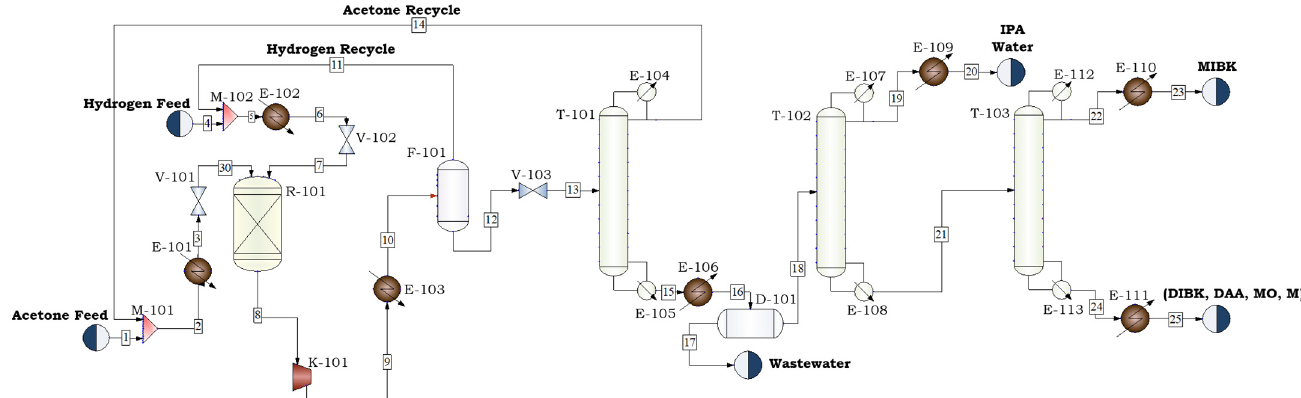
Figure 1. Developed process flow diagram (PFD) of the MIBK process.